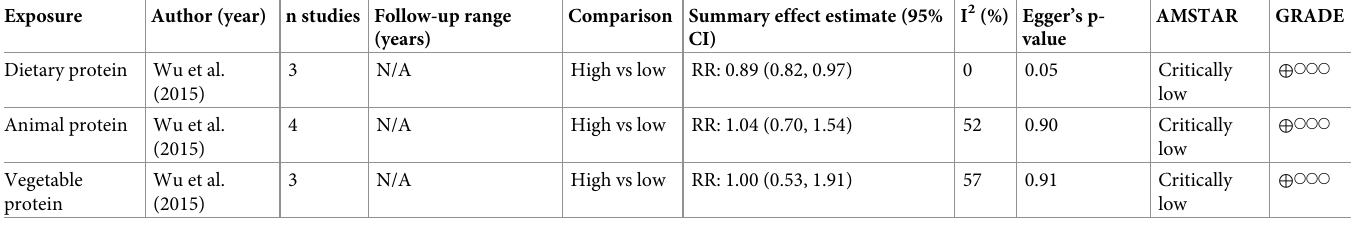
Table 3. Summary characteristics and findings of meta-analyses of cohort studies assessing associations between dietary intake of macronutrients and hip fracture risk. Exposure